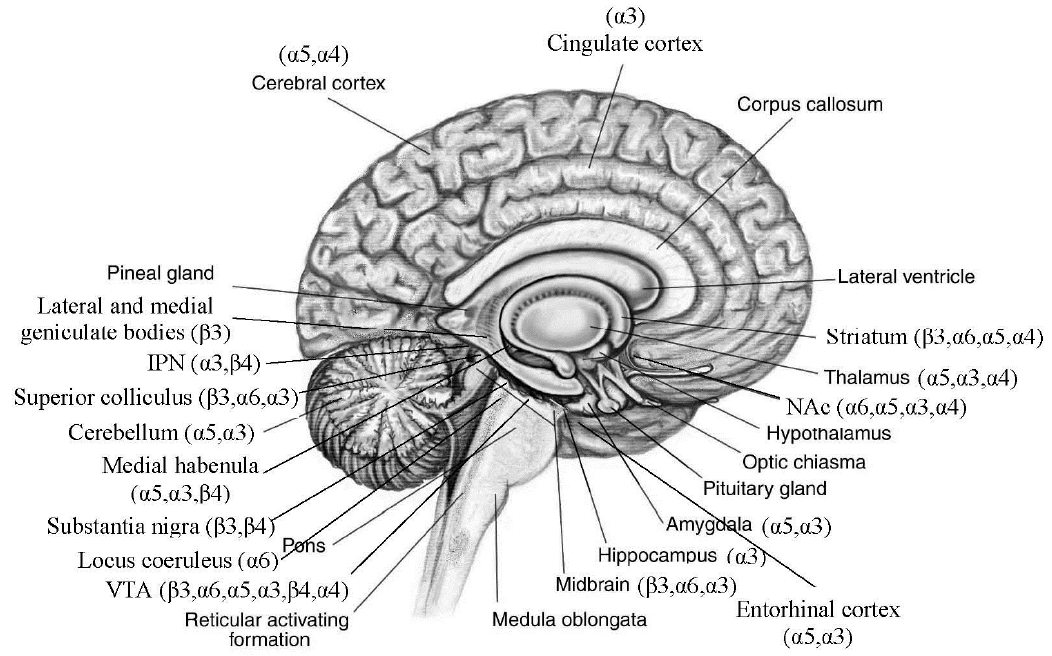
Figure 1. Distribution of nAChR subunits in brain.